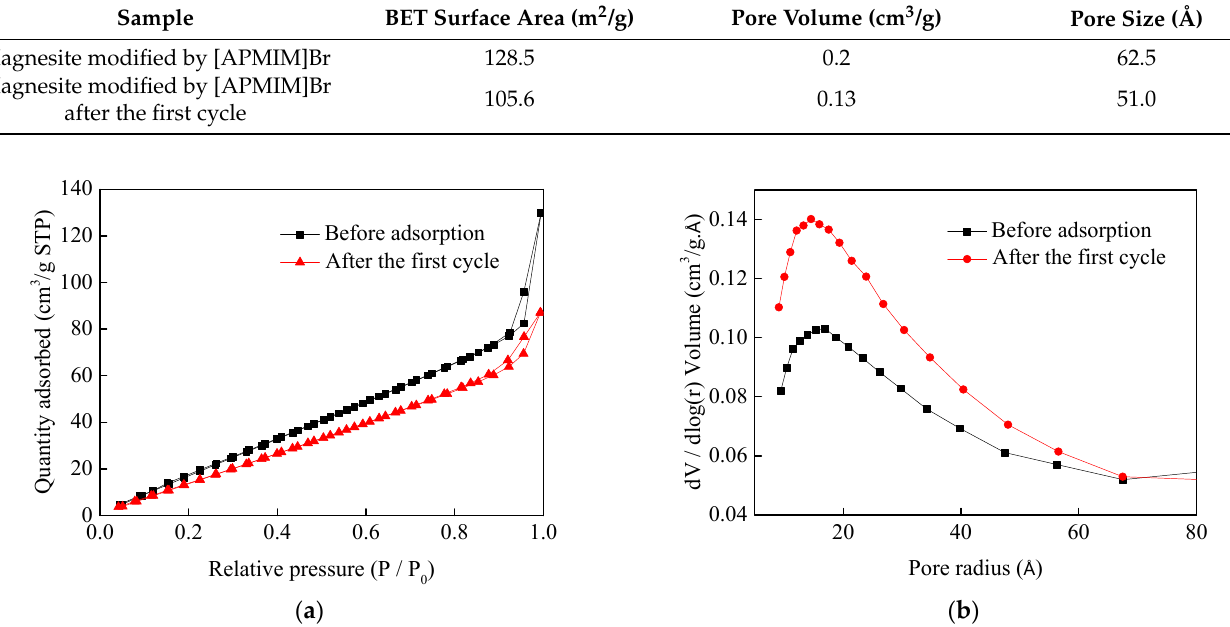
Figure 12. N 2 adsorption-desorption isotherms ( a ) and pore size distributions ( b ) of magnesite modified by [APMIM]Br before and after the first cycle.